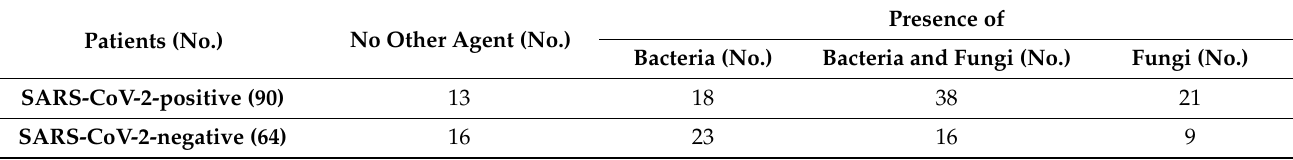
Table 1. Infectious agents detected in the overall 301 lower respiratory tract samples.